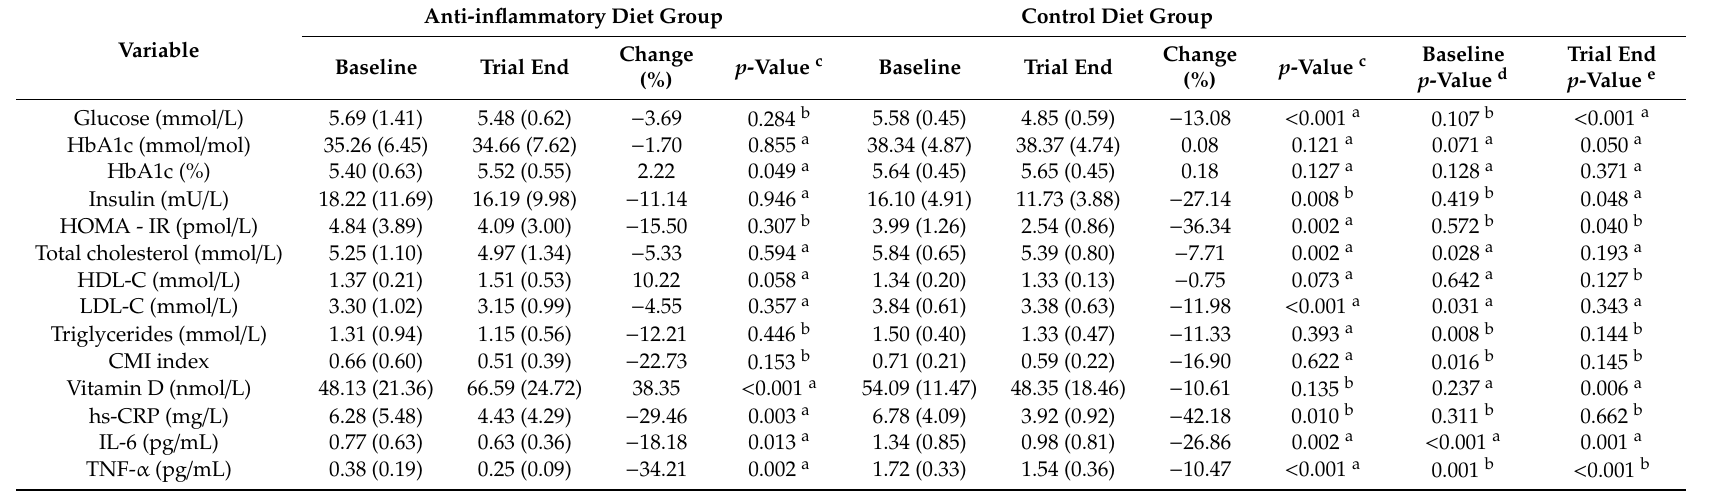
Table 4. The changes in the cardiometabolic and inflammatory